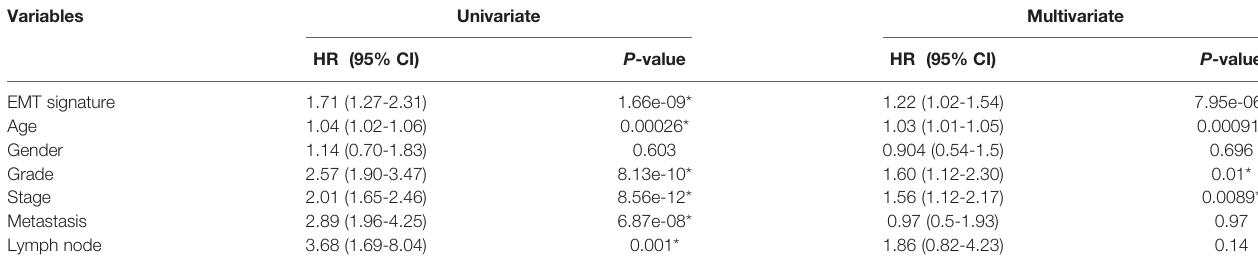
TABLE 1 | Univariate and multivariate Cox proportional hazard regression analysis of overall survival in the cohorts (n = 252).